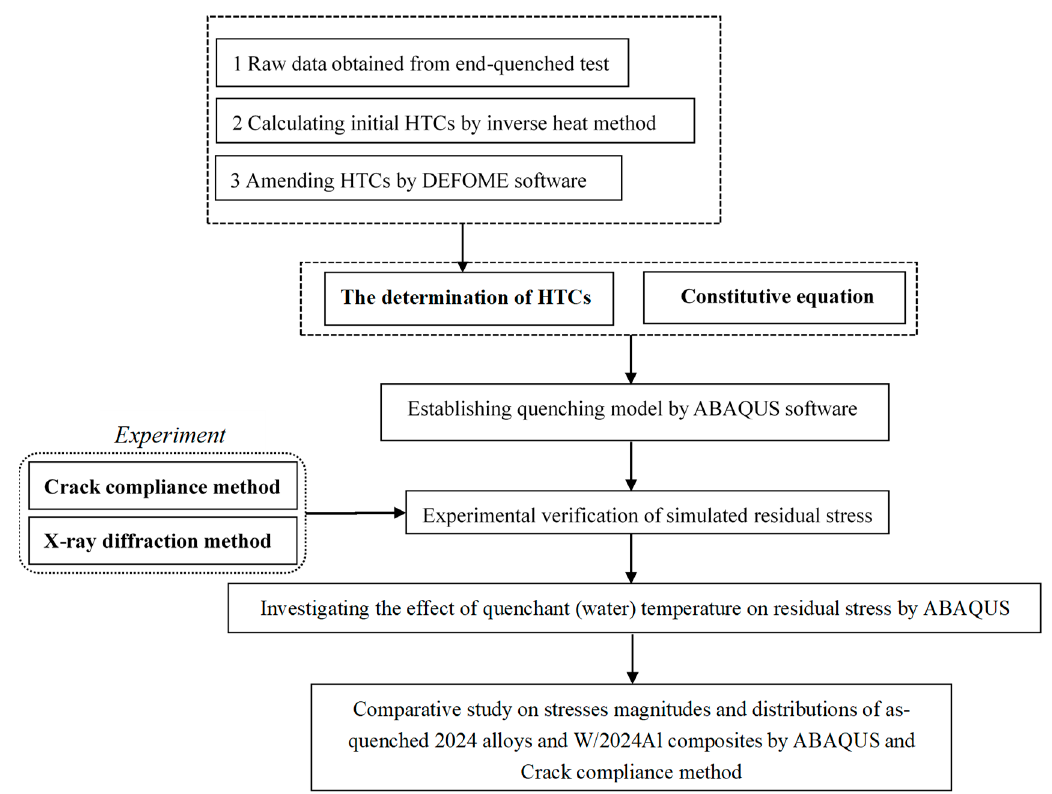
Figure 4. Flowchart of the research procedure.